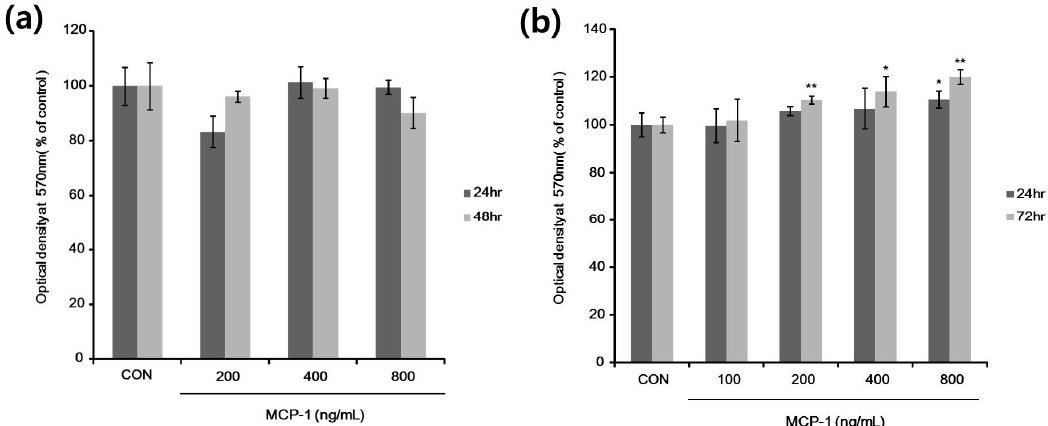
Figure 3. In vitro cell proliferation evaluated using the 3-(4,5-dimethylthiazol-2-yl)-2,5-diphenyl tetrazolium bromide (MTT) assay. ( a ) Normal human keratinocytes (NHKs) were treated with 200–800 ng/mL MCP-1 for the indicated times; ( b ) NHMs were treated with 100–800 ng/mL MCP-1 for the indicated times, followed by addition of MTT, and absorbance was then measured at 570 nm in a microplate reader. * p < 0.05, and ** p < 0.01 by the Student‘s t -test.